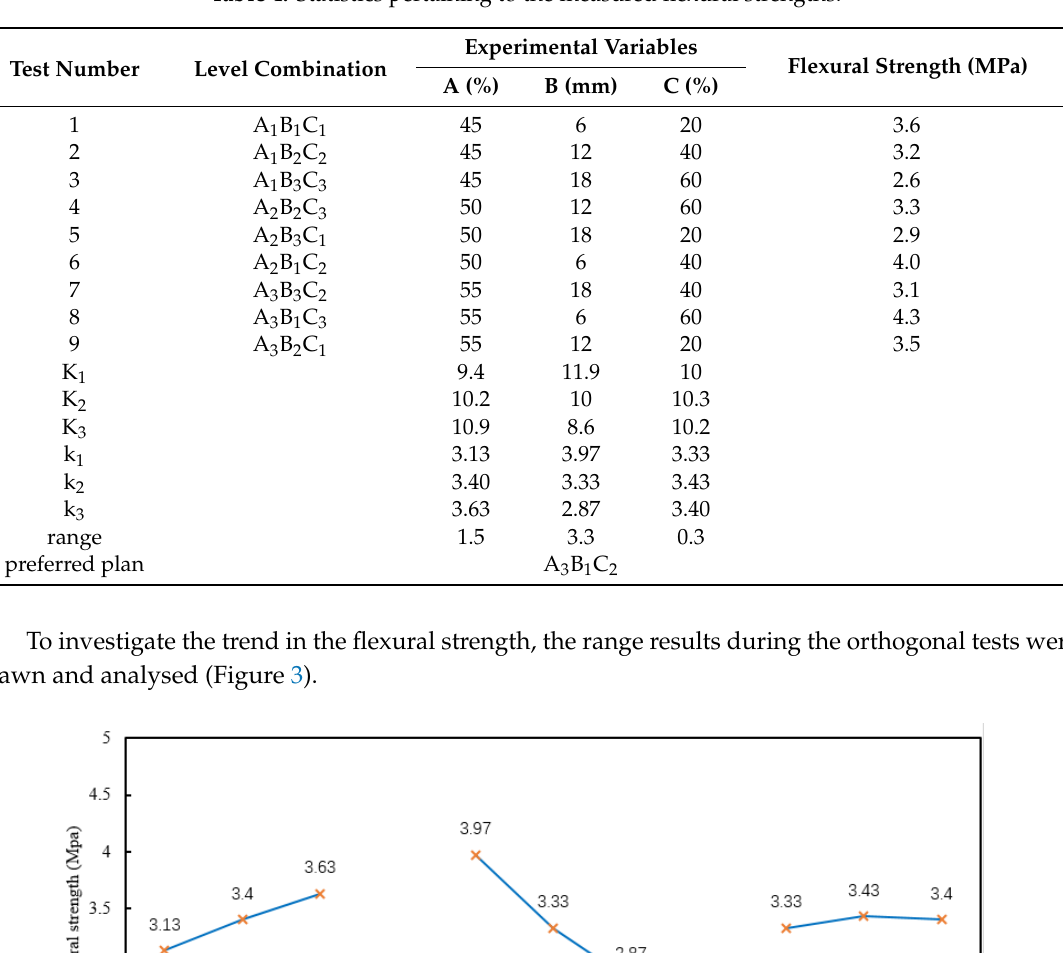
Table 4. Statistics pertaining to the measured flexural strengths.